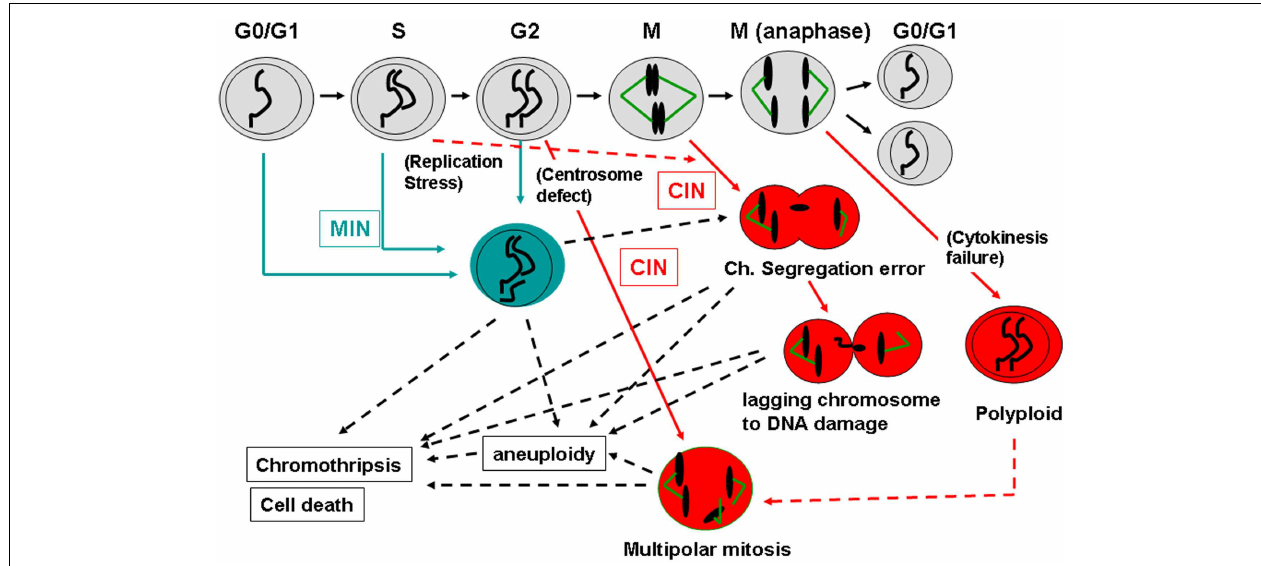
mitotic chromosome structure, centrosome mis-regulation that results in multipolar mitosis). CIN-mediated chromosome mis-segregation can lead further to DNA damage, directly caused by cytokinesis machinery or in the process of chromothripsis (Janssen et al., 2011; Crasta et al., 2012). Failures in cytokinesis and subsequent p53-dependent removal of the cell result in generation of a polyploid cell. Polyploidy can lead to aneuploid offspring cells via multipolar mitosis (Shi and King, 2005). Since p53 is involved in centrosome regulation and clustering in addition to removal of aneuploid/polyploid cells, loss of p53 can permit a polyploid-multipolar mitosis-aneuploid cycle, which would be highly detrimental to genomic